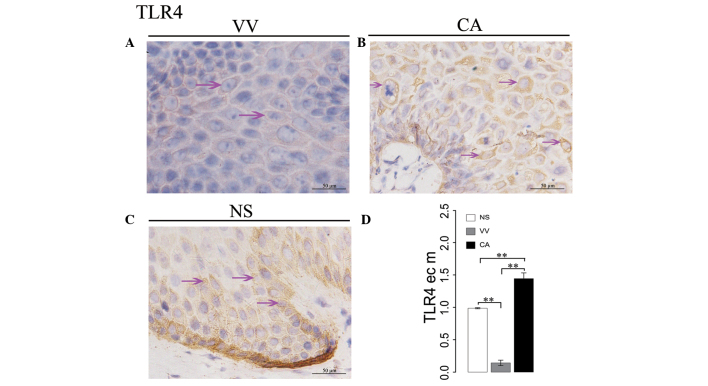
TLR4 expression in NS and wart samples by immunohistochemistry EnVision (magnification, ×400). (A to C) Purple arrows represent TLR4 expression on the epithelium membranes. (D) **P<0.01 of TLR4 on epithelial cell membranes in the different tissues. The error bars represent the standard error of the mean. TLR4, toll like receptor 4; CA, condyloma acuminatum; VV, verruca vulgaris; NS, normal skin.